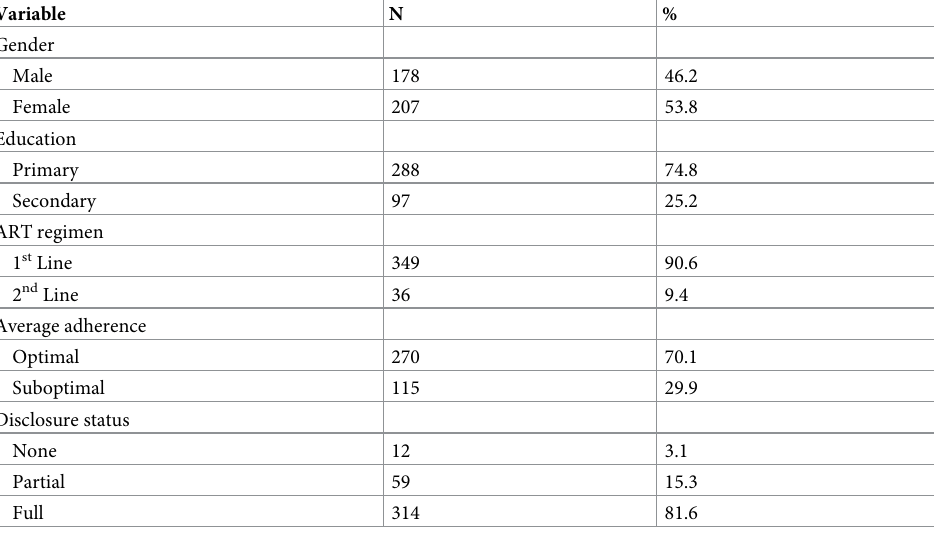
Table 1. Summary of sample